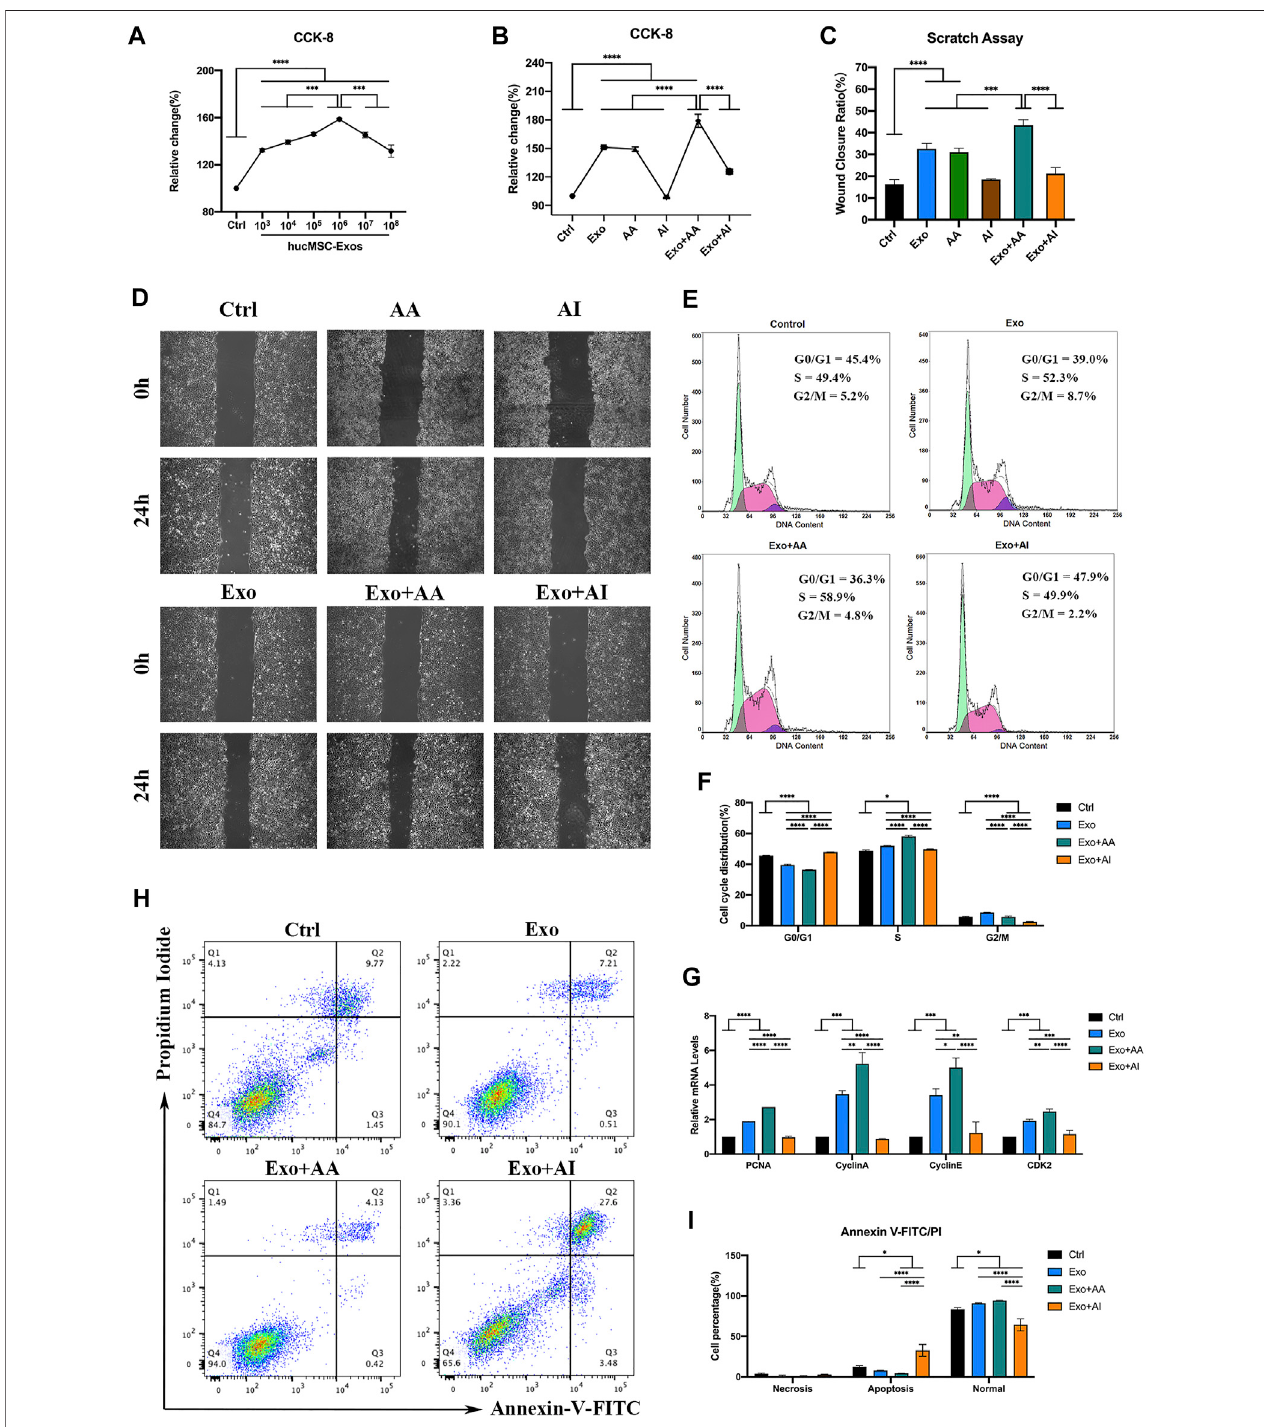
FIGURE 3 | Effects of the combination of hucMSC-Exos and autophagy regulators on HCECs. (A) Cell-counting Kit-8 (CCK-8) assay for cell viability of HCECs incubated with different concentrations of hucMSC-Exos for 24 h (B) CCK-8 assay for cell viability of HCECs in Control, Exo, AA, AI, Exo + AA and Exo + AI groups for 24 h. (C,D) Scratch assay results for cell migration rates of HCECs in Control, Exo, AA, AI, Exo + AA and Exo + AI groups for 24 h. Scale bar: 250 μ m. (E,F) Flow cytometry results for cell cycle composition of HCECs after combination treatment with hucMSC-Exos and autophagy regulators for 24 h. (G) Quantitative PCR results for mRNA expression of PCNA, Cyclin A, Cyclin E and CDK2 in HCECs. (H, I) Apoptosis assay results showing the proportion of HCECs at each phase after the treatmentwithhucMSC-Exoscombinedwithautophagy regulators for24 h.Dataareshown asmean±SD. *p < 0.05,**p < 0.01,***p < 0.001,****p < 0.0001.(Control: HCECstreatedwithPBS,Exo:HCECstreatedwith1×10 6 / μ lhucMSC-Exos,Exo+AA:HCECstreatedwith1×10 6 / μ lhucMSC-Exosand50 nMRapamycin,Exo+AI: HCECs treated with 1 × 10 6 / μ l hucMSC-Exos and 5 μ M Compound C).